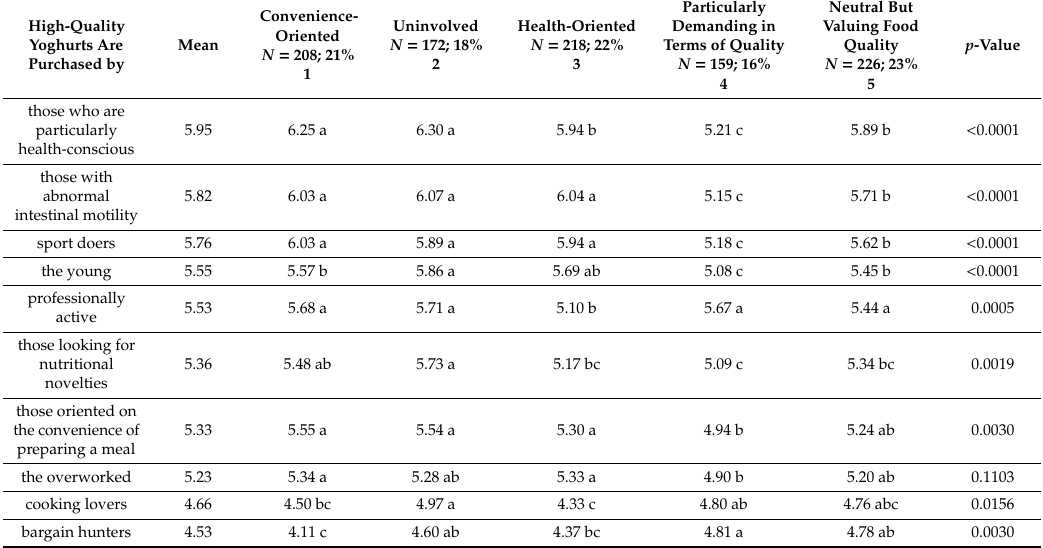
Table 6. Projective image of high-quality yoghurt